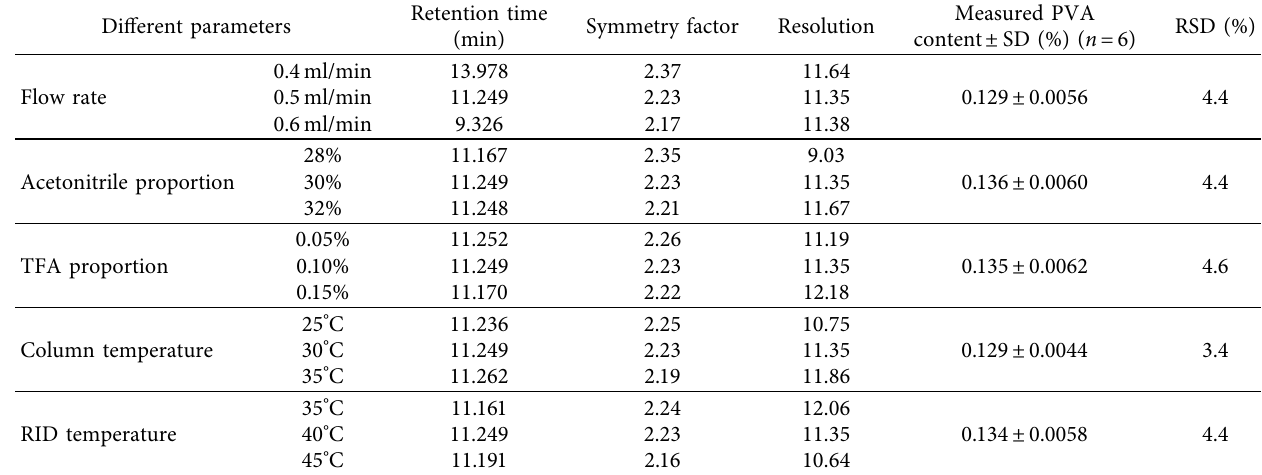
Table 5: Robustness results under different chromatographic conditions.